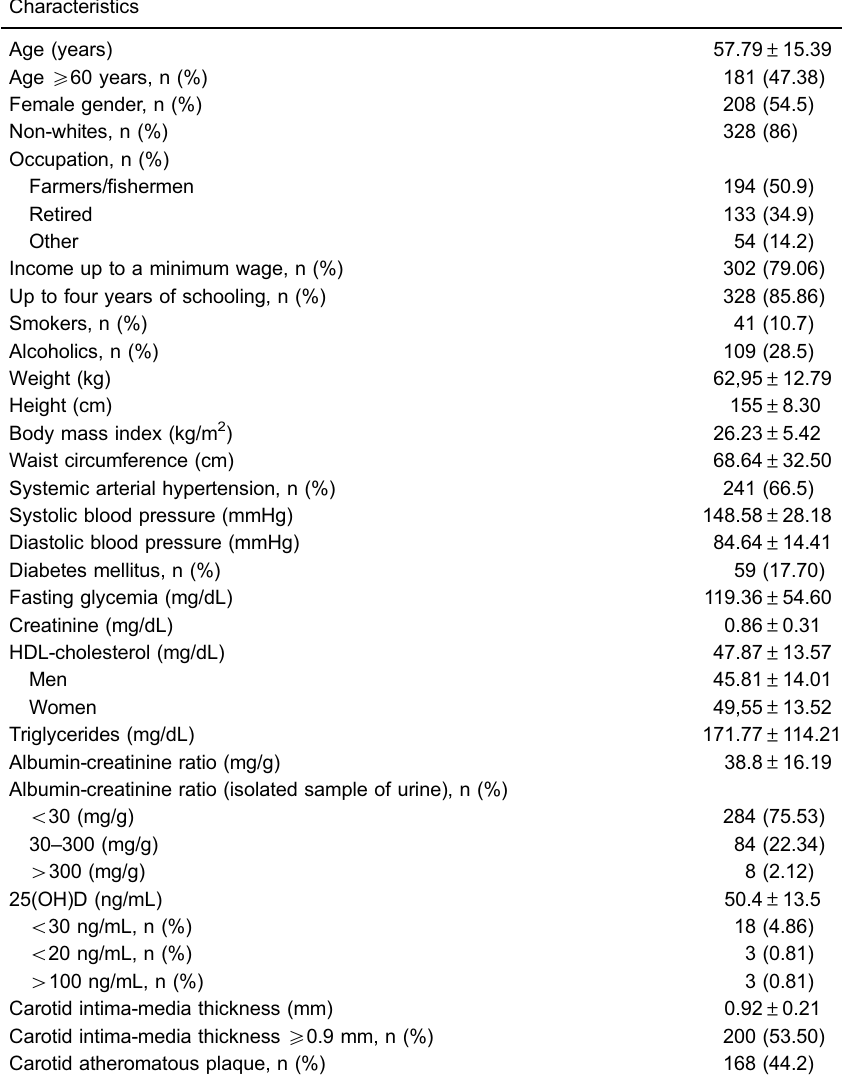
Table 1. Socio-demographic, clinical, anthropometric and laboratory characteristics of the study population (n=382).